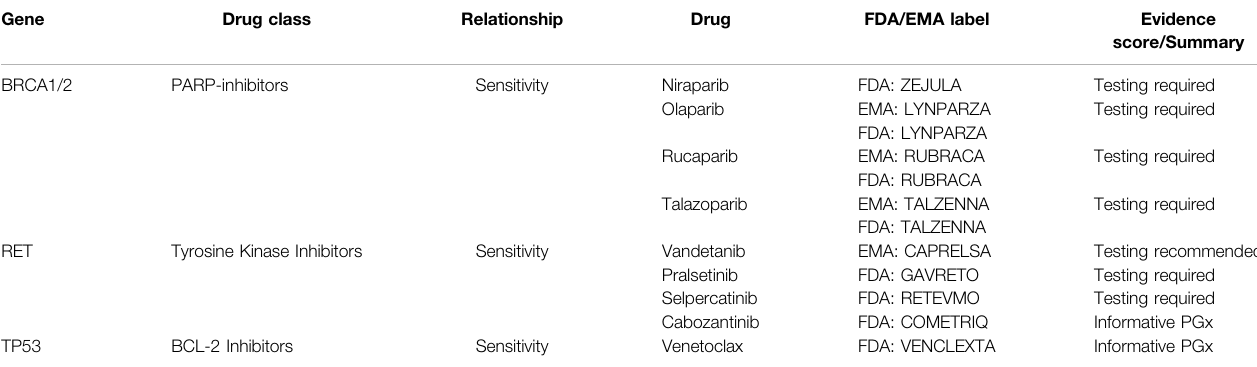
TABLE 2 | PharmGKB drug label